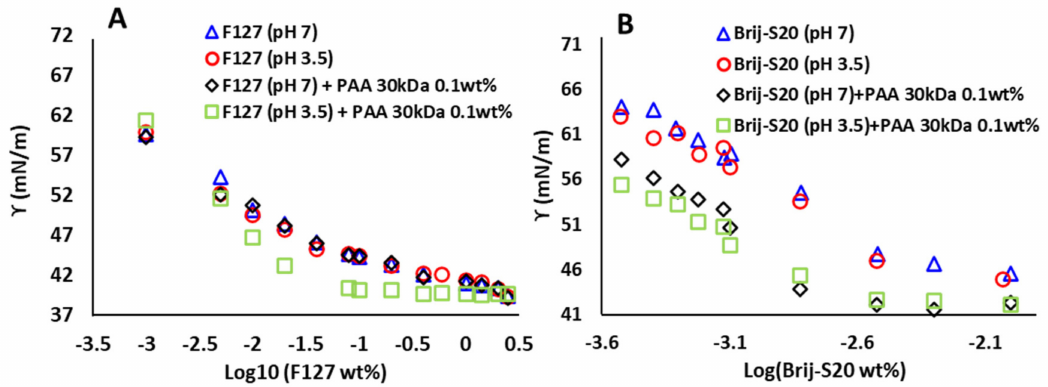
Figure 4. Surface tension vs. log concentration measured via Du Nouy ring method in solutions of ( A ) F127 and ( B ) Brij-S20. pH = 7 (blue), pH = 3.5 (red), solutions of PAA 30 kDa (0.1 wt%) at pH = 7 ( black ) and at pH = 3.5 (green). The error in the measurements is 0.1